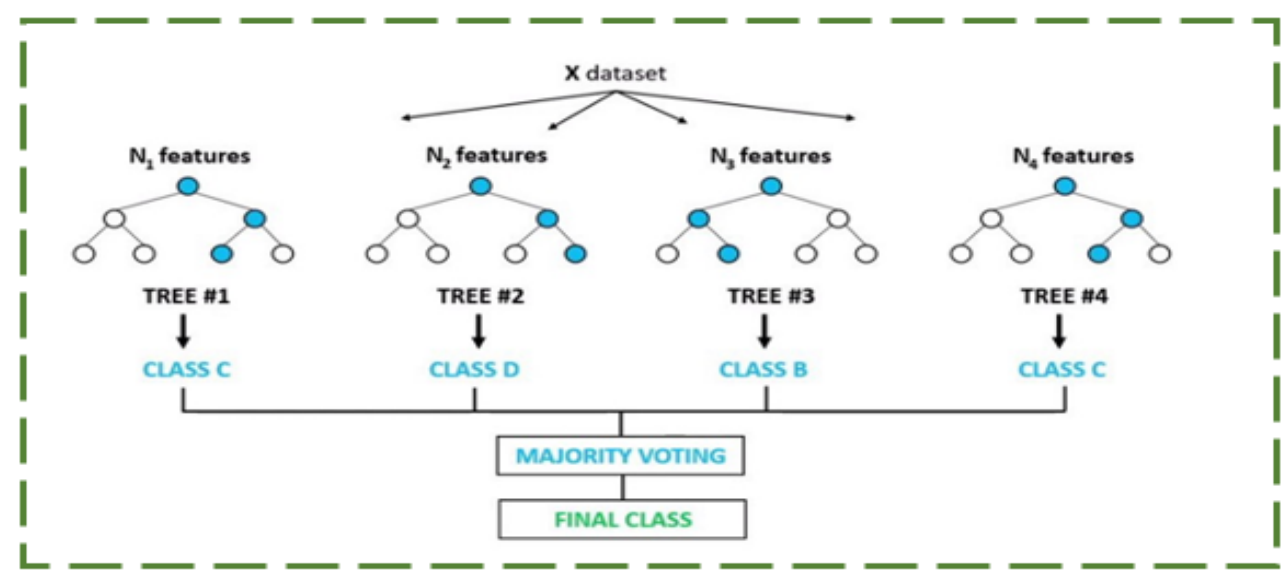
Figure 8. Random Forest Classifier Architecture.